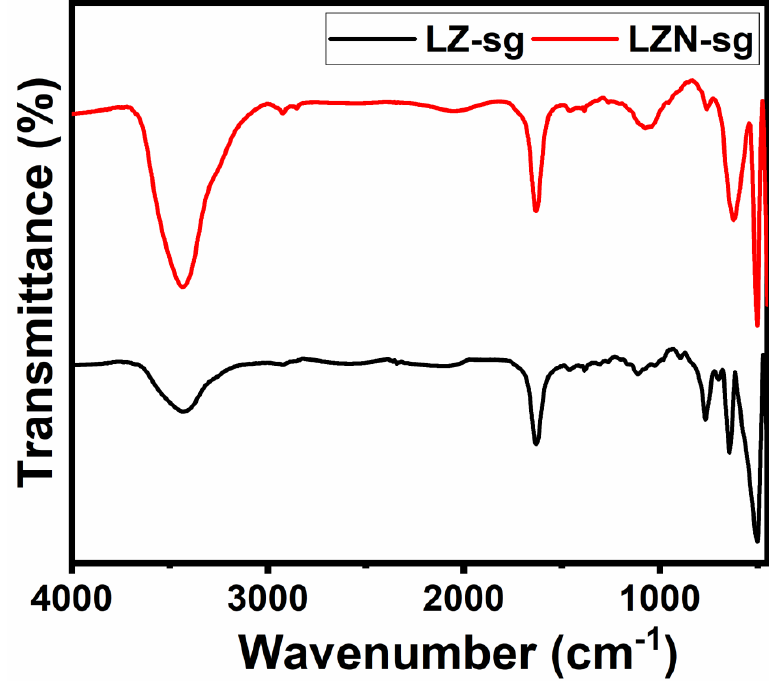
Figure 7. FT-IR spectra of LZ-sg and LZN-sg pyrochlores.